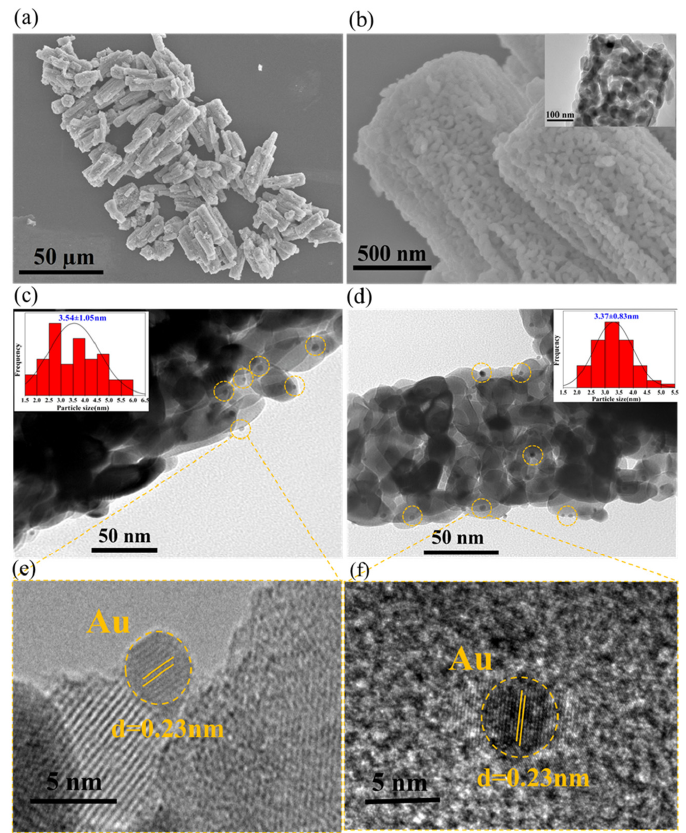
Figure 2. SEM and TEM images of the as-prepared NiTiO 3 sample ( a , b ). TEM and HRTEM images of 0.26 Au/NiTiO 3 sample ( c , e ) and 0.85 Au/NiTiO 3 ( d , f ). The inserts in ( c ) and ( d ) are the Au particle size distributions in the as-prepared 0.26 Au/NiTiO 3 and 0.85 Au/NiTiO 3 samples, respectively. The general morphology of the Au/NiTiO 3 samples remains very similar to the Ni- TiO 3 sample. However, when examining closely, tiny particles of Au crystals can be seen well-dispersed in the two Au-loaded samples, as highlighted in dashed yellow circles (Figure 2d,e). The HRTEM images reveal the highly crystalline nature of the Au particles and lattice d- spacing of d = 0.23 nm (Figure 2e,f), consistent with Au(111) [34]. The average sizes of the Au crystals are found to be 3.47 ± 1.12 nm for the 0.26 Au/NiTiO 3 sample (insert in Figure 2c) and 3.37 ± 0.83 nm for the 0.85 Au/NiTiO 3 sample (insert in Figure 2d). The low Au loading, very small crystal sizes and well-dispersed distribution are the likely reasons that Au was not convincingly detected in the XRD analysis of the Au/NiTiO 3 sam- ples. Table 1 summarize the measured BET surface areas of the NiTiO 3 and Au/NiTiO 3 samples, as well as the weight percent of Au-loading measured by the ICP. The BET sur- face area of the samples did not change significantly with the Au-loading. This is con- sistent with the observation that Au particles are very small of <5 nm and well-dispersed on the surface of NiTiO 3 rods. The Au-loadings determined by the ICP analysis are con- sistent with the nominal loading of the two samples.